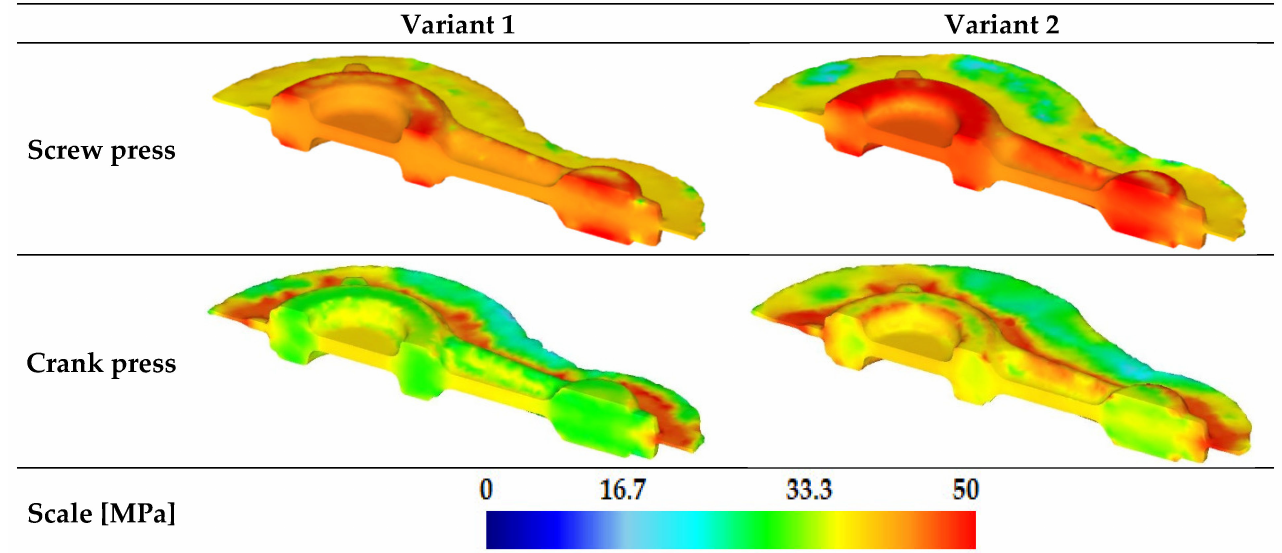
Figure 19. Distribution of effective stress for connecting rod forgings made of AB-71100 aluminum alloy formed based on the new